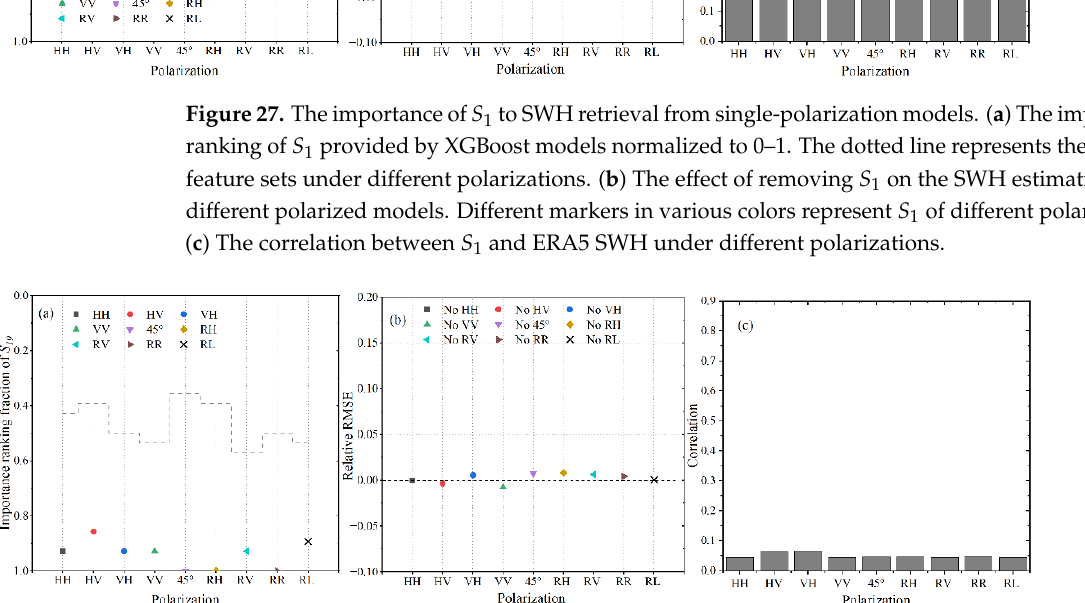
Figure 28. The importance of S 19 to SWH retrieval from single-polarization models. ( a ) The importance ranking of S 19 provided by XGBoost models normalized to 0 – 1. The dotted line represents the optimal feature sets under different polarizations. ( b ) The effect of removing S 19 on the SWH estimation from different polarized models. Different markers in various colors represent S 19 of different polarizations. ( c ) The correlation between S 19 and ERA5 SWH under different polarizations.